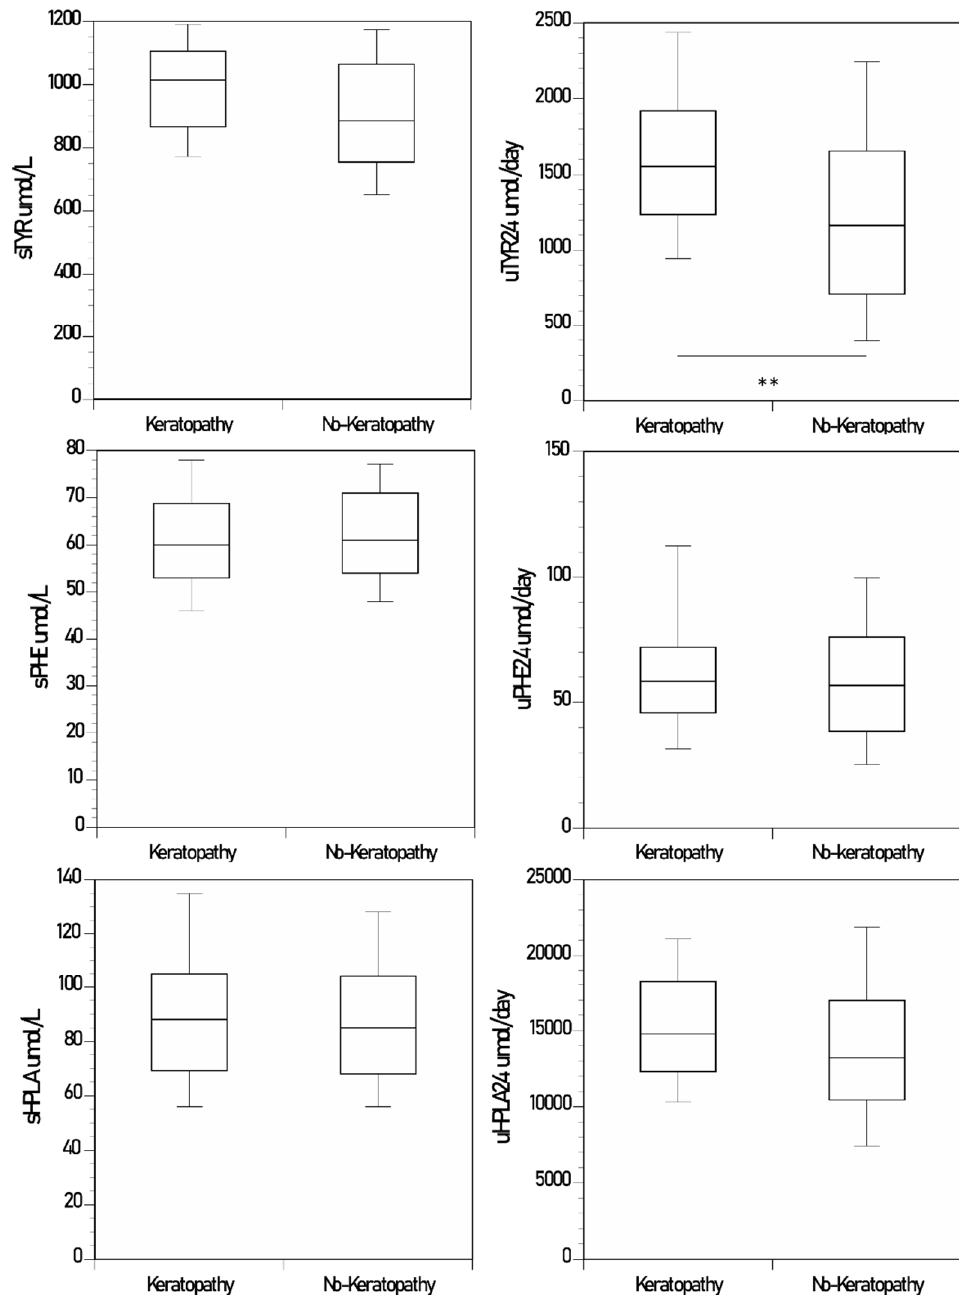
Figure 1. Changes in sTYR and uTYR 24 , sPHE and uPHE 24 , and sHPLA and uHPLA 24 in the nitisinone group of the SONIA 2. ( p -values indicated for comparison between keratopathy and no-keratopathy sampling points where statistical significance was achieved; keratopathy sampling points n = 35; no-keratopathy sampling points n = 272) (data shown as boxplots with median) (statistical significance p expressed * < 0.05, ** < 0.01, and *** < 0.001 respectively).